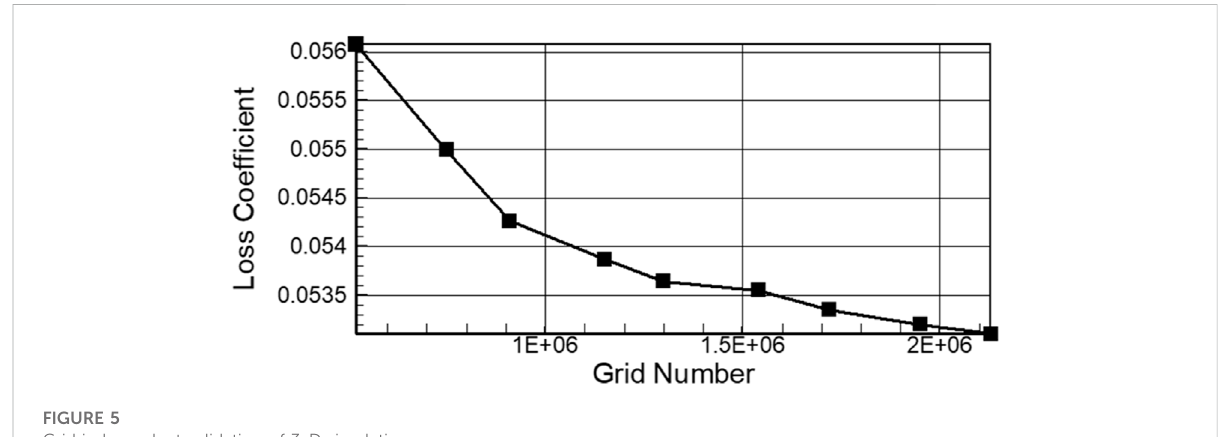
FIGURE 5 Grid independent validation of 3-D simulation.